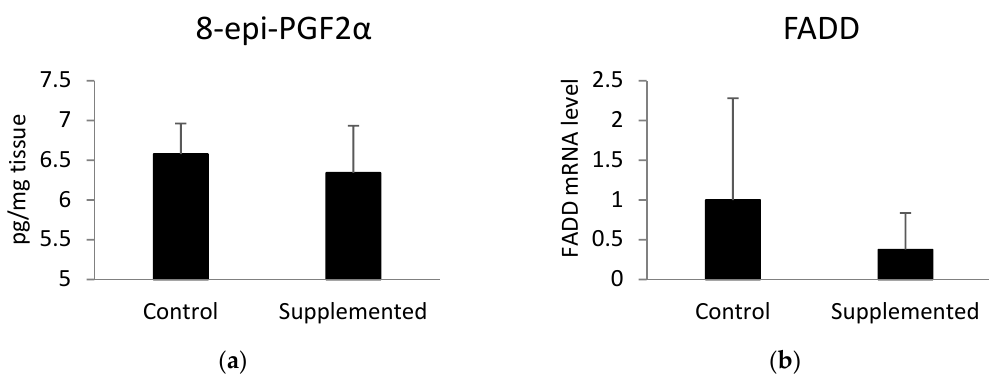
Figure 3. ( a ) Concentration of muscle 8-epi-prostaglandin F2 α (8-epi-PGF2 α ) measured using ELISA test and ( b ) the mRNA level of Fas-associated via death domain ( FADD ) determined by quantitative real-time PCR. Statistical differences were analyzed using unpaired t -tests.